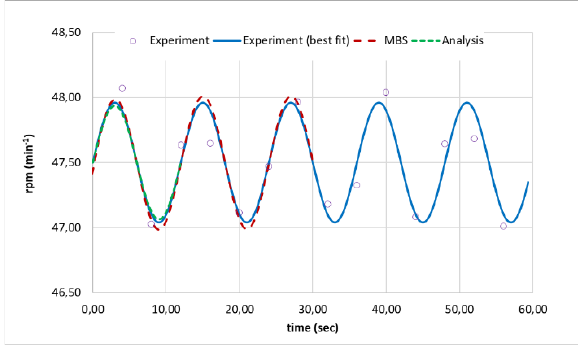
Fig. 10. Comparison of the achieved